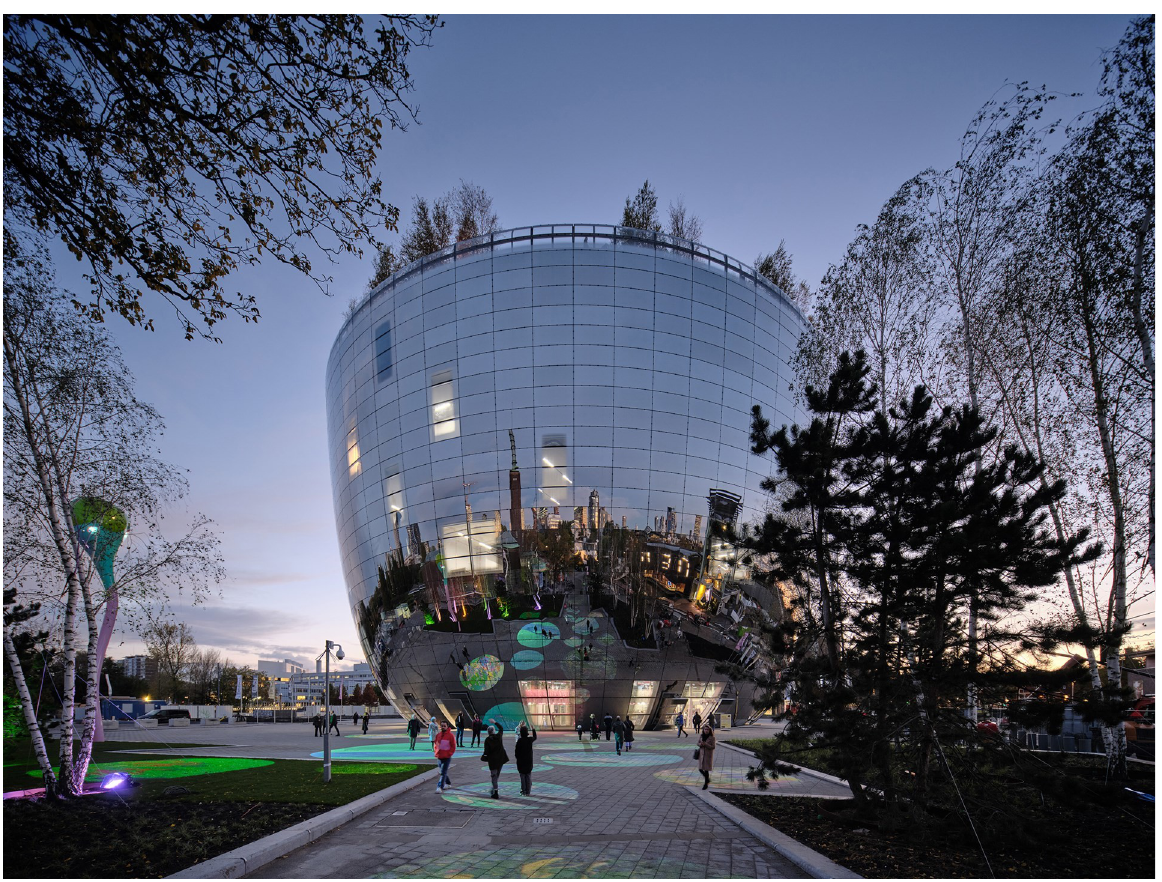
Fig 2. Visualisation of the exterior view of the Depot Boijmans Van Beuningen (MVRDV © Ossip van